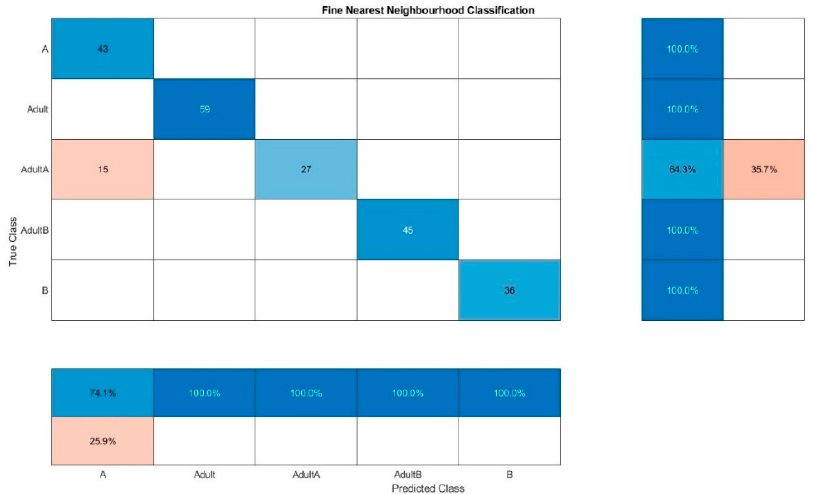
Figure 7. Confusion matrix for the oil classification by KNN out of the combined evaluation of the fluorescence and NIR spectra.